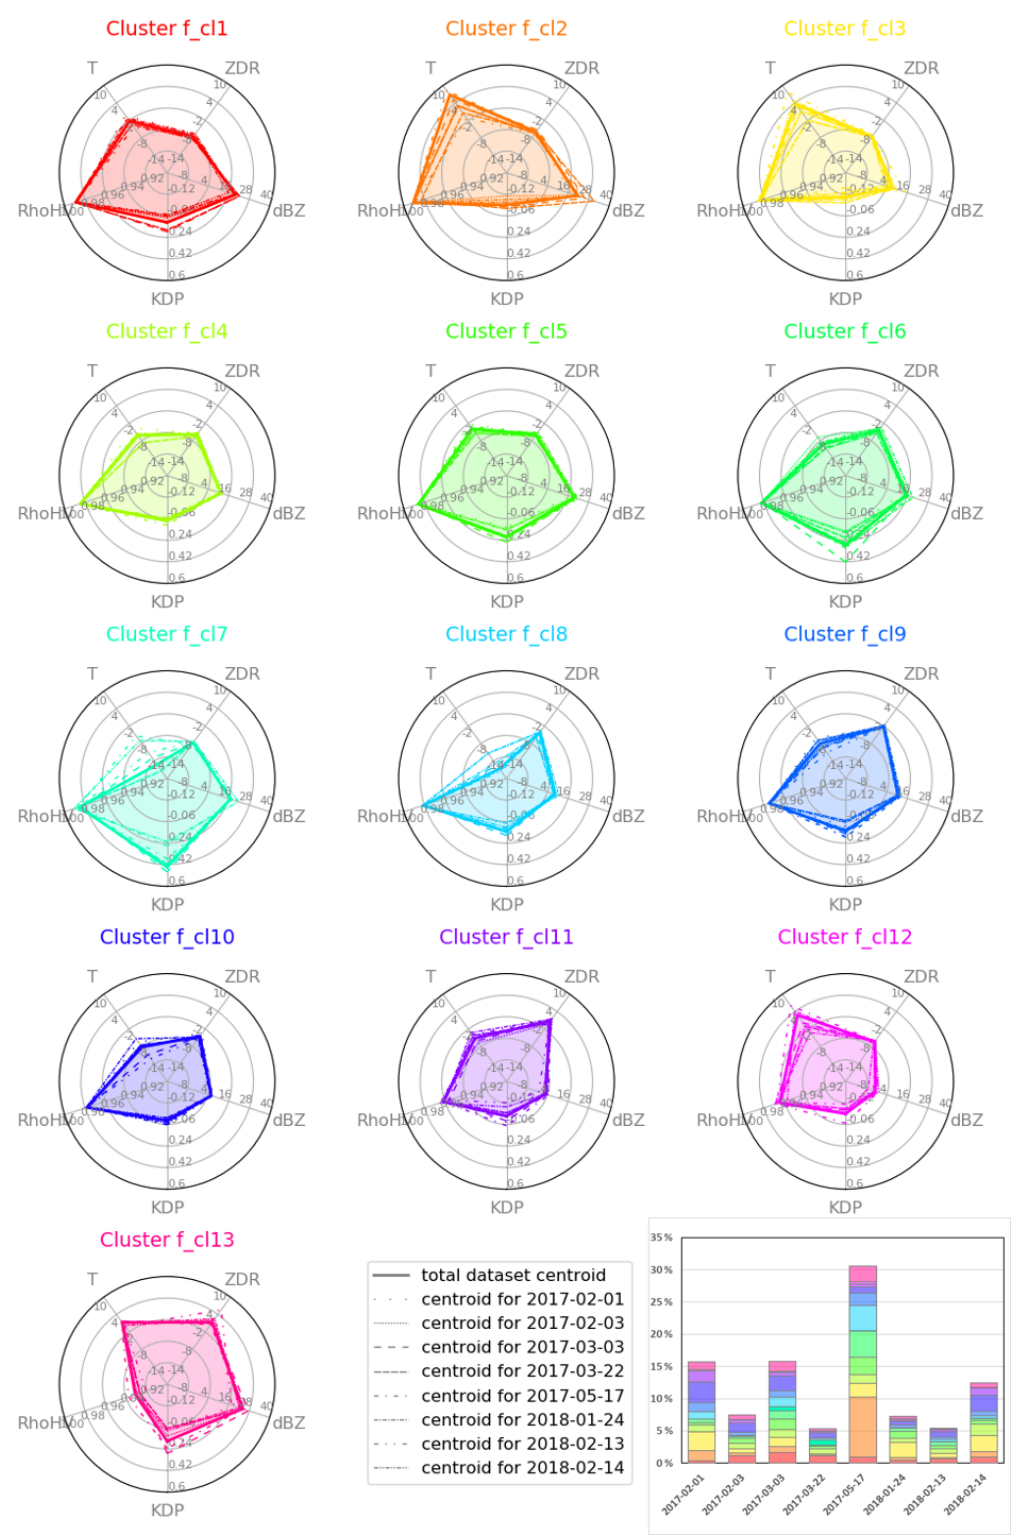
Figure 7. Characteristics of the optimal clustering centroids in four polarimetric variables and temperature. The scales of the variables are as follows: from − 20 to 40dBZ for Z H , from − 1 . 5 to 2.0dB for Z DR , from 0.9 to 1.0 for ρ HV , from − 0 . 3 to 0.6 ◦ km − 1 for K DP and from − 20 to 10 ◦ C for temperature ( T